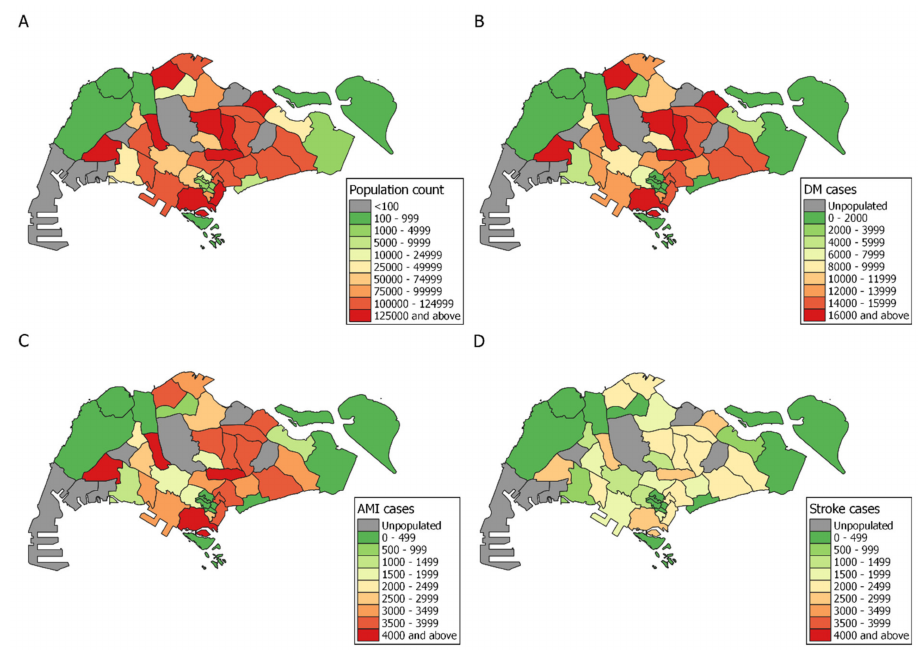
Figure 1. National-level maps of ( A ) population count ( B ) diabetes mellitus (DM) ( C ) acute myocar- dial infarction (AMI) and ( D ) stroke case numbers aggregated by planning area. Areas with less than 100 residents were defined as unpopulated and are coloured gray. Simpang and Seletar Island have been omitted as fewer than 10 individuals reside in these